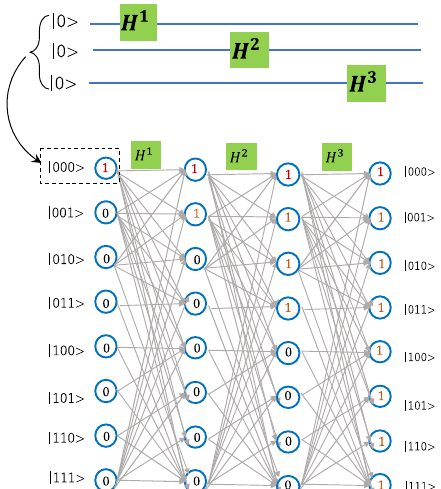
Figure 1. Example of three-gate quantum circuit and its corresponding fully connected quantum network, showing similarity to a four-layer neural network with equal numbers of nodes in the input layer, middle layer, and output layer. Note that the amplitude value is not normalized for better eye-guiding illustration.